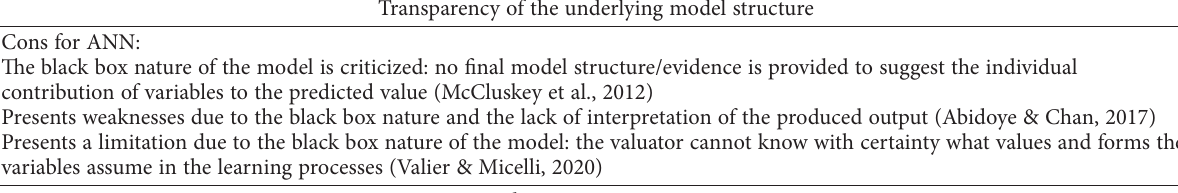
Table 1. ANN versus regression models: pros and cons Transparency of the underlying model